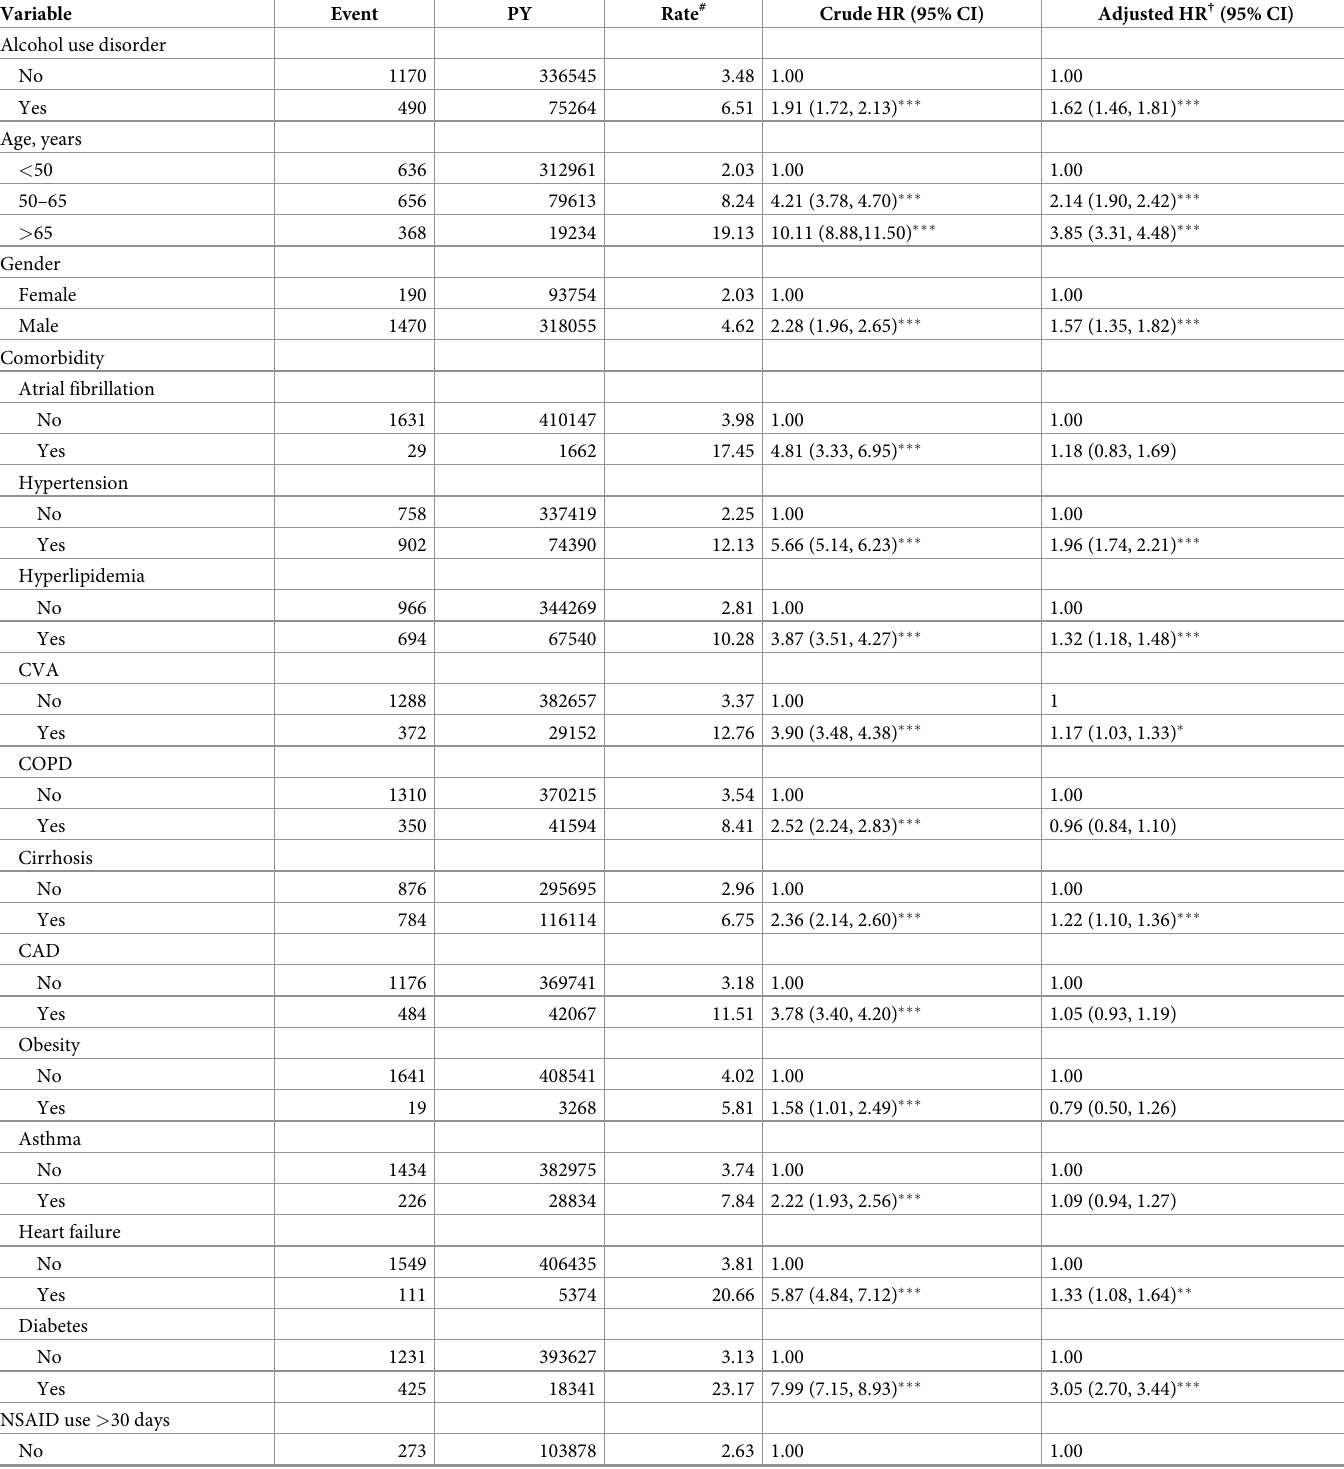
Table 2. The incidences and risk factors for developing chronic kidney disease of study